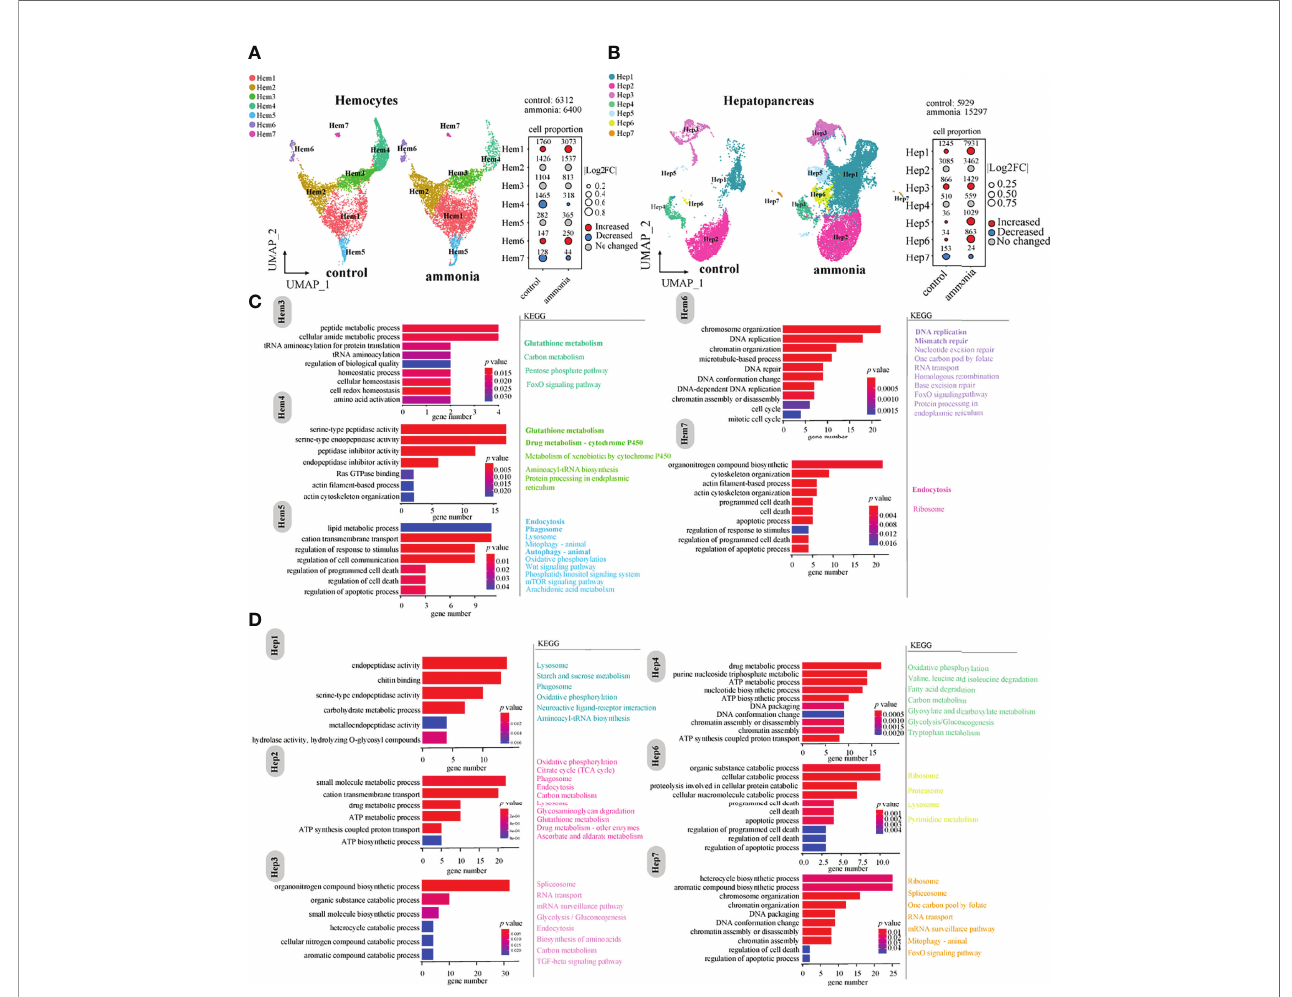
FIGURE 2 | The changes of cell clusters under ammonia-stress and enrichment of marker genes in P. monodon haemocytes and hepatopancreas (A) UMAP of haemocytes in the control (CG) and ammonia-treated groups (AG). The bubble chart represents the changes in the cell ratio of each cell cluster in haemocytes. (B) UMAP of hepatopancreas in the AG and CG. The bubble chart represents the changes in the cell ratio of each cell cluster in hepatopancreas. (C) GO and KEGG enrichment analysis of marker genes in haemocytes. (D) GO and KEGG enrichment analysis of marker genes in